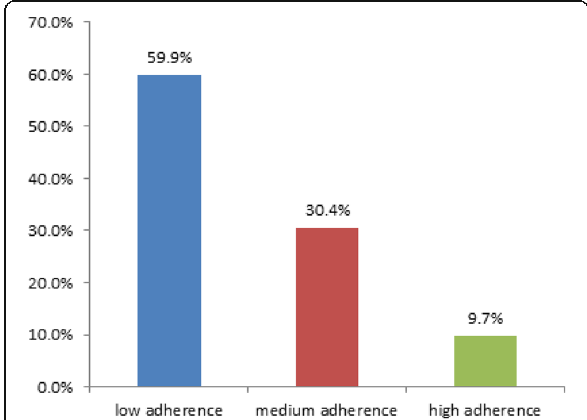
Fig. 1 Distribution of MS patients ’ medication adherence